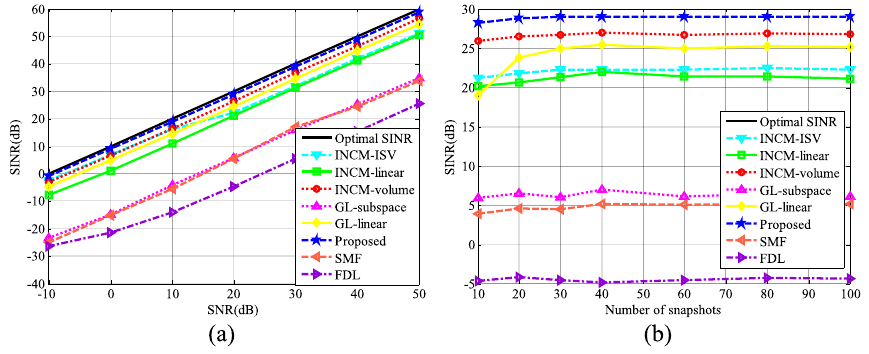
Fig. 8 Comparison of SINR. a SINR against SNR. b SINR against number of